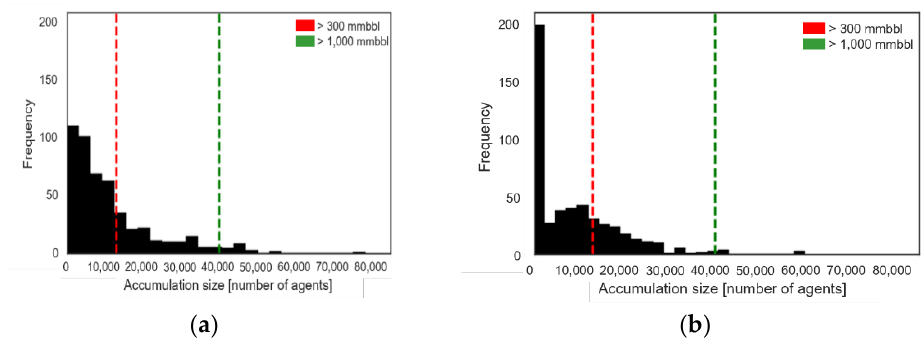
Figure 7. Accumulation size distribution of the most significant accumulation in the fault block trap ( a ) and anticlinal trapping structure ( b ). The red vertical line shows the limit for accumula- tions of economic value (300 mmbbl); the green line shows the limit for accumulation greater than 1000 mmbbl.